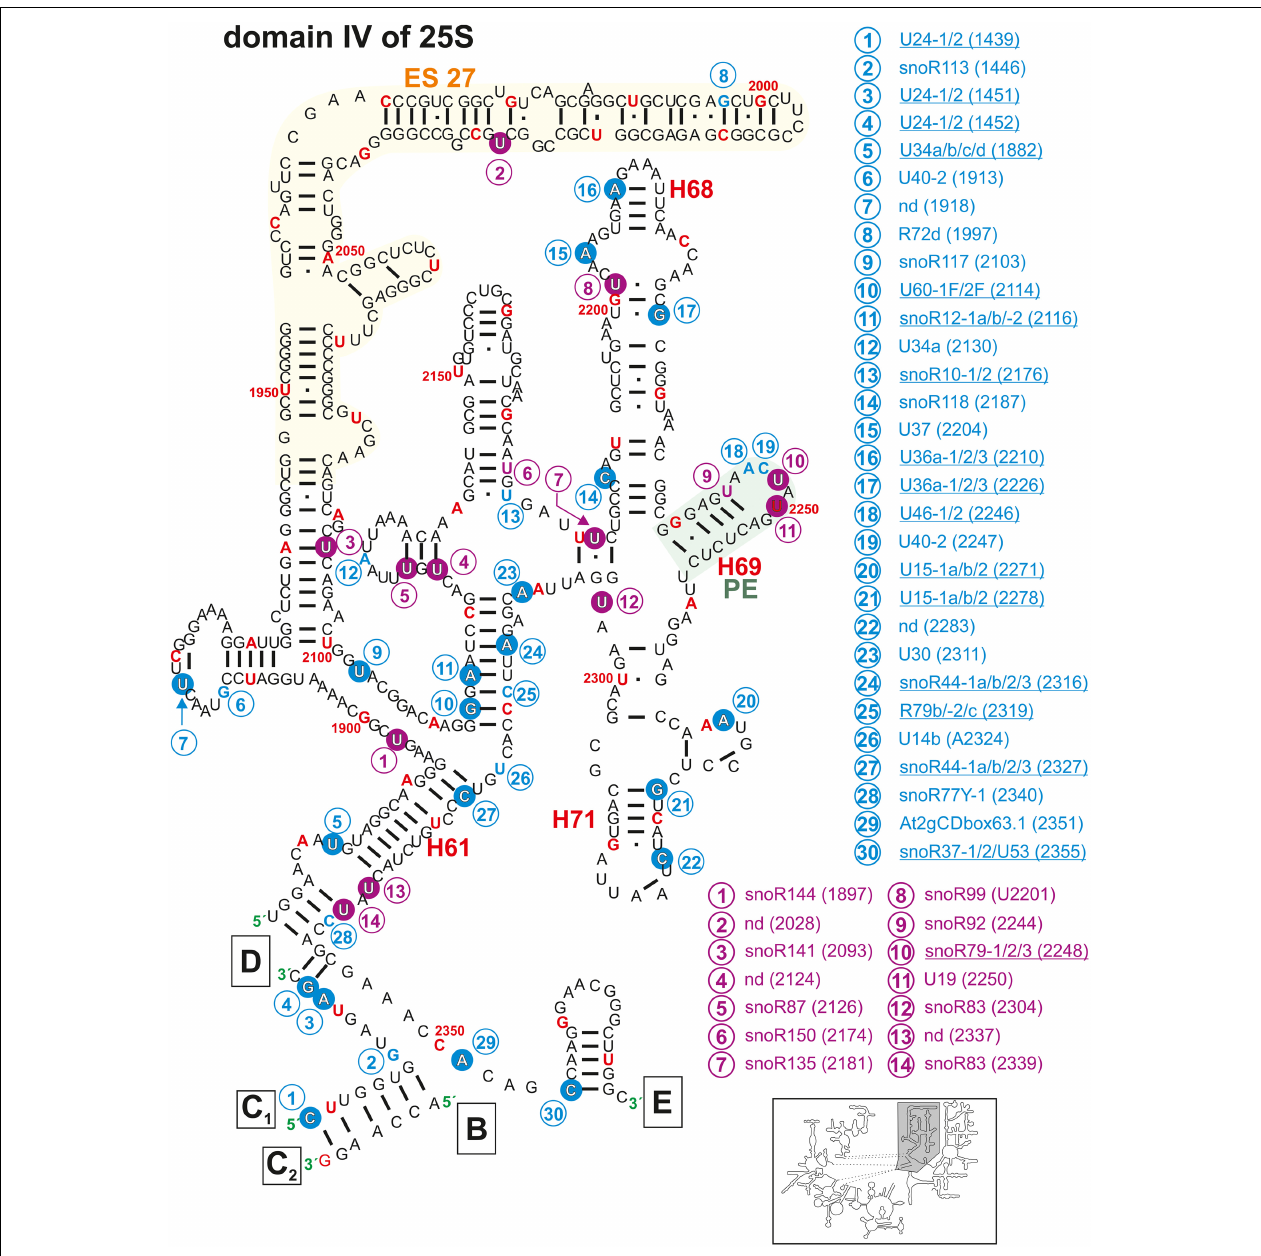
FIGURE 6 | Secondary structure diagram of domain IV of 25S rRNA of A. thaliana . The image is shown according to the legend for Figure 3 . Framed large letters indicate the position of the connections in subsequent images (for B see Figure 4 ; for C see Figure 5 ; for D see Figure 4 ; for E see Figure 7 ). The number in brackets correspond to the modified nucleotide position. A small illustration of the whole 60S rRNA secondary structure highlighting the according region is